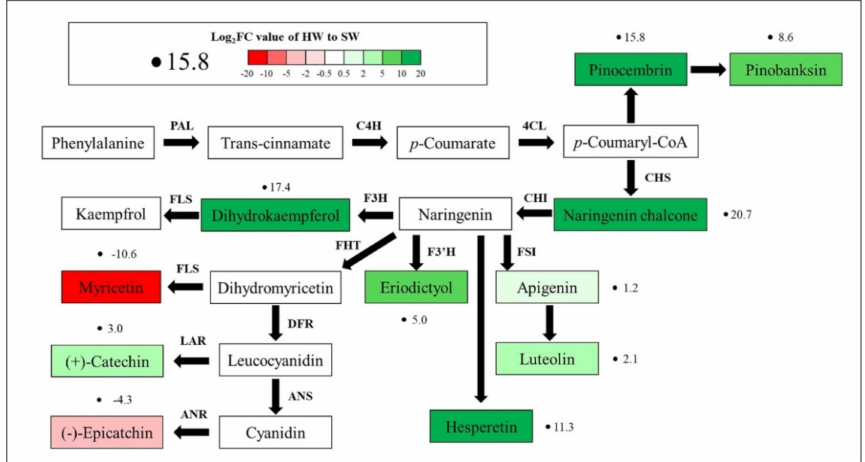
Figure 5. Chemical structure and contents of 8 significant differential flavonoids metabolites in the heartwood and sapwood of the red-heart Chinese fir. Means with different lowercase letters are significantly different at p ≤ 0.05.